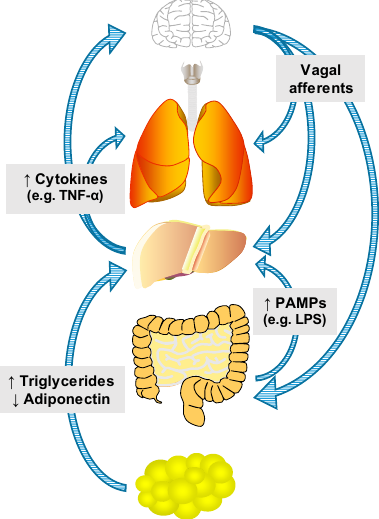
Figure 2. The liver at the center of organ–organ axes. There are several physiologic and pathophysiologic mechanisms by which inter-organ communication can be mediated, such as via nutrients, hormones and hepatokines (see Section 3.1), afferent and efferent innervation (Section 3.2), release of extracellular vesicles (Section 3.3), cytokines (Section 3.4) and pathogen-associated molecular patterns (PAMPs) and damage-associated molecular patterns (DAMPs) (Section 3.5). LPS: lipopolysaccharide; TNF- α : tumor necrosis factor- α .